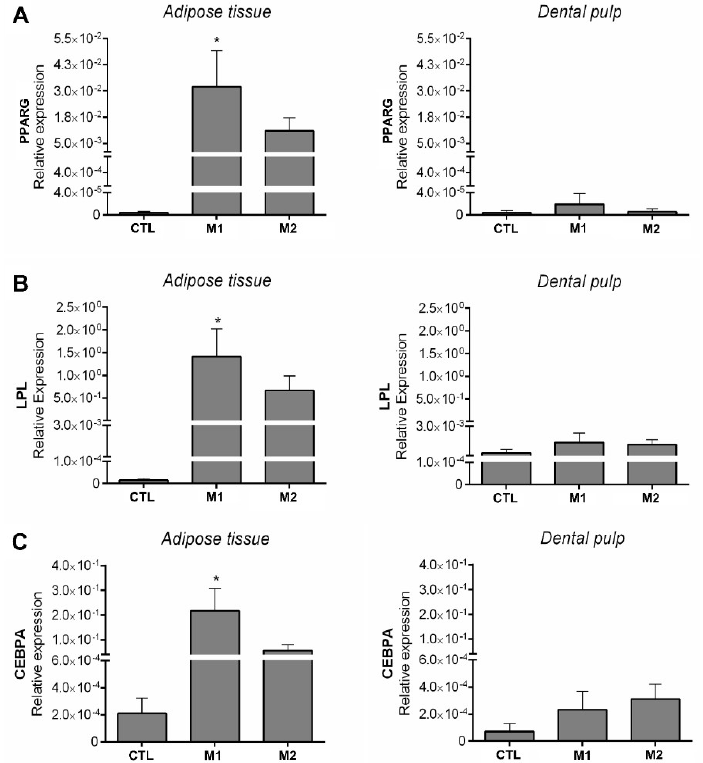
Figure 3. Expression of PPARG, LPL and CEBPA by qRT-PCR. The mRNA levels of markers of adipogenesis were measured by quantitative real-time PCR and normalised to GAPDH levels. ( A ) Expression of PPARG in ADSCs and DPSCs, ( B ) expression of LPL in ADSCs and DPSCs, ( C ) expression of CEBPA in ADSCs and DPSCs. CTL: control; M1: commercial culture medium; M2: